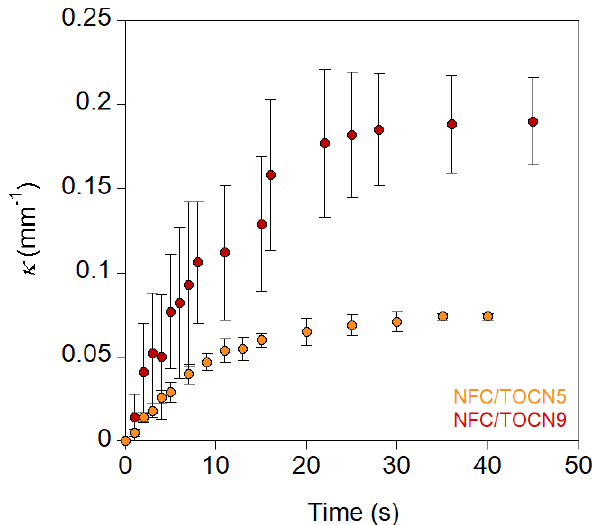
Figure 4. Curvature of the NFC/TOCN nanopapers as a function of time when they were immersed in high pH aqueous solutions (pH 13).